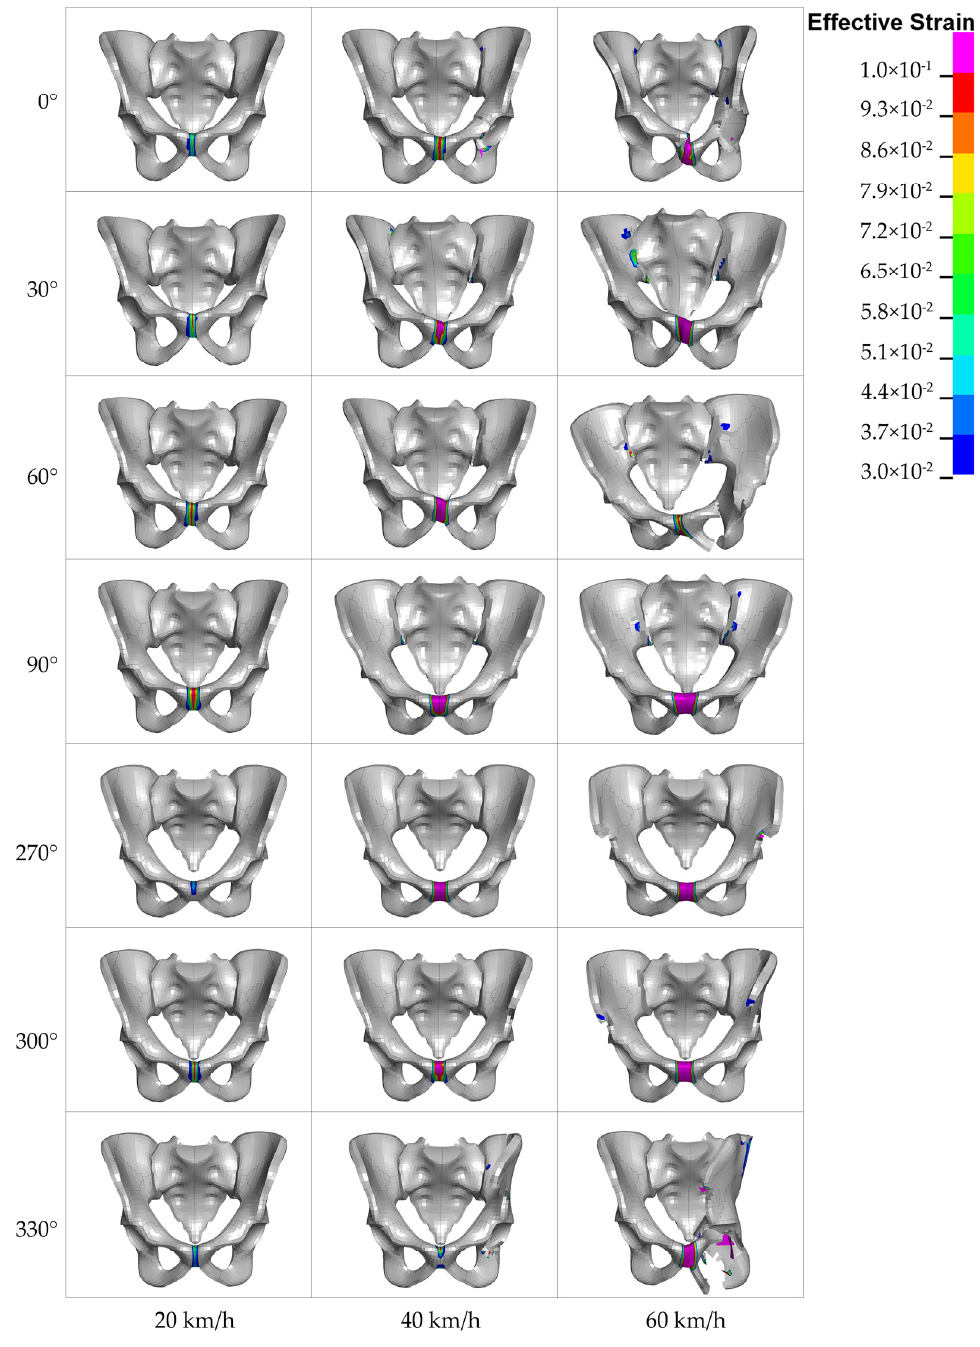
Figure 7. The pelvic deformation, fractures and effective strain contours ( ≥ 0.03) in the simulation results of impact loading conditions.